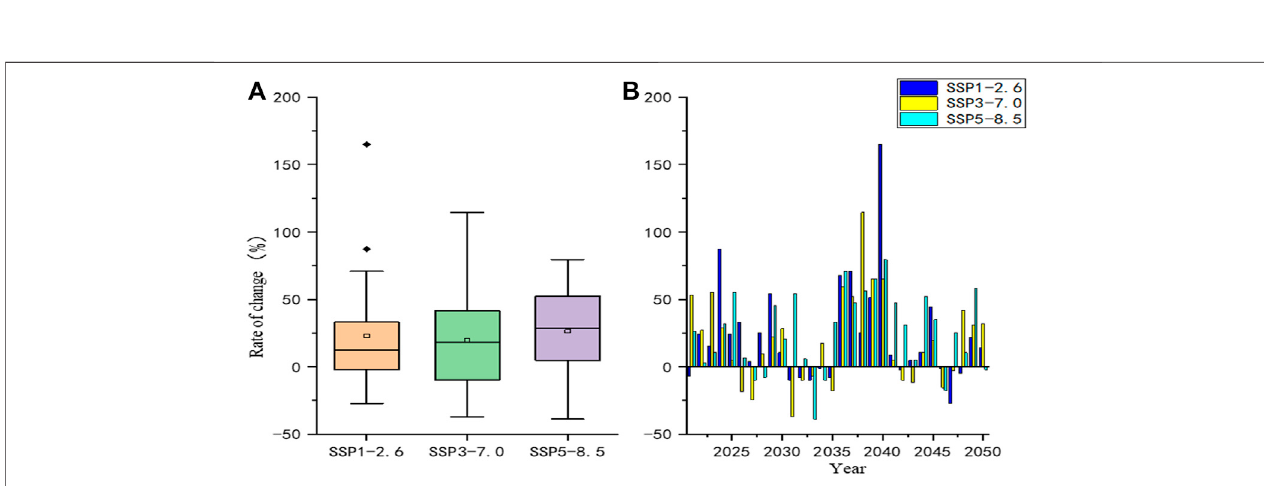
FIGURE5| Changepercentageofextremeprecipitationfrequencyunderdifferentscenariosinthefuture. (A) Averagechangepercentage. (B) Changepercentage of each year.